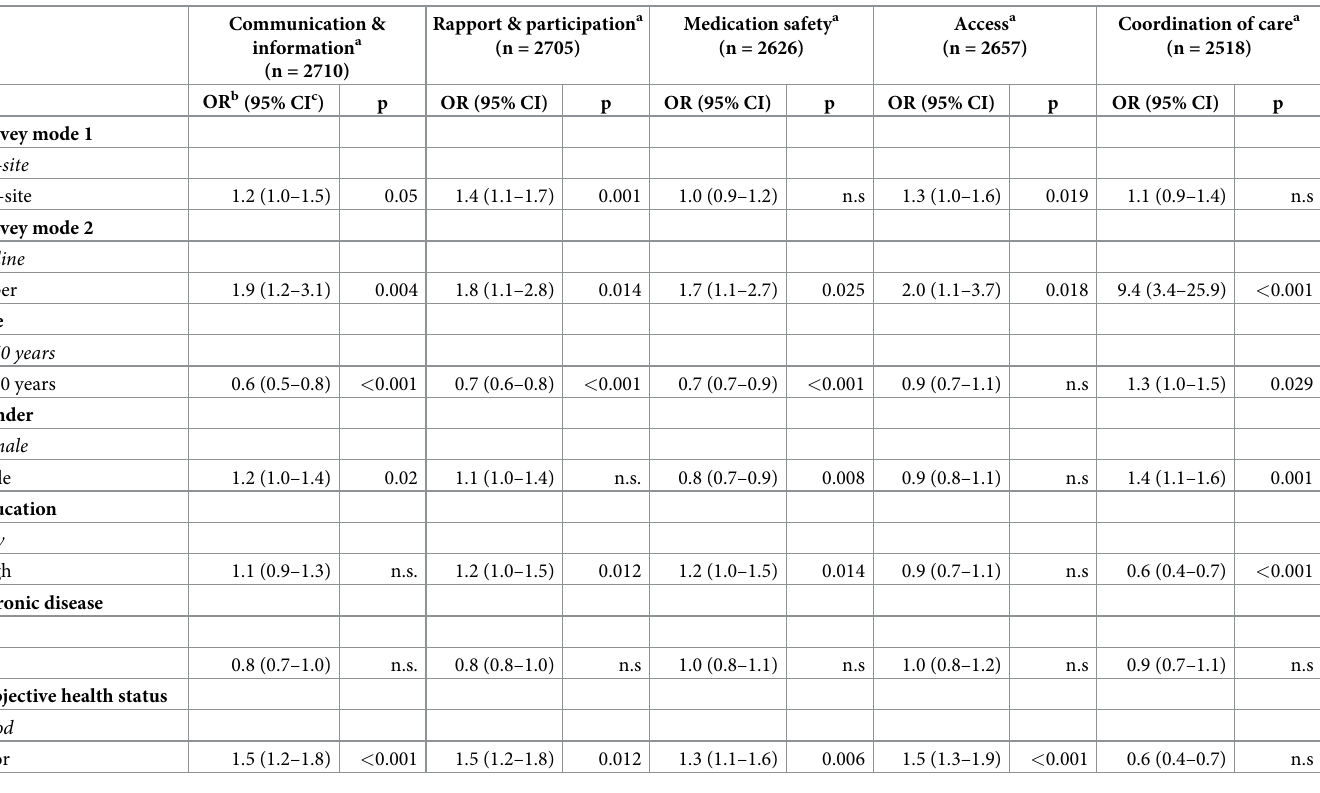
Table 5. Effect of survey mode and patient characteristics on patient experience with factors contributing to PSE. Communication & information